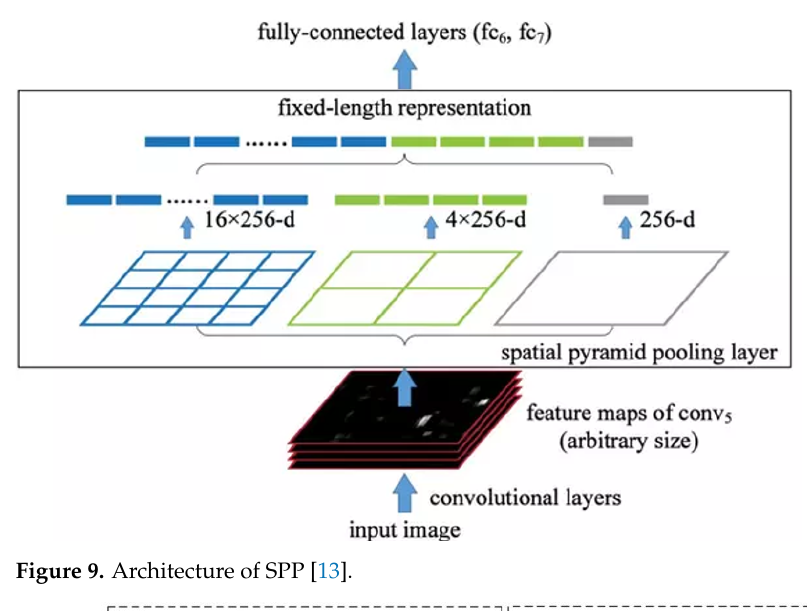
Figure 8. The architecture of CSPBlock in CSPDarknet53 [27]. ( a ) The simple CSP connection. ( b ) A CSP connection in YOLOv4-CSP/P5/P6/P7 [13].